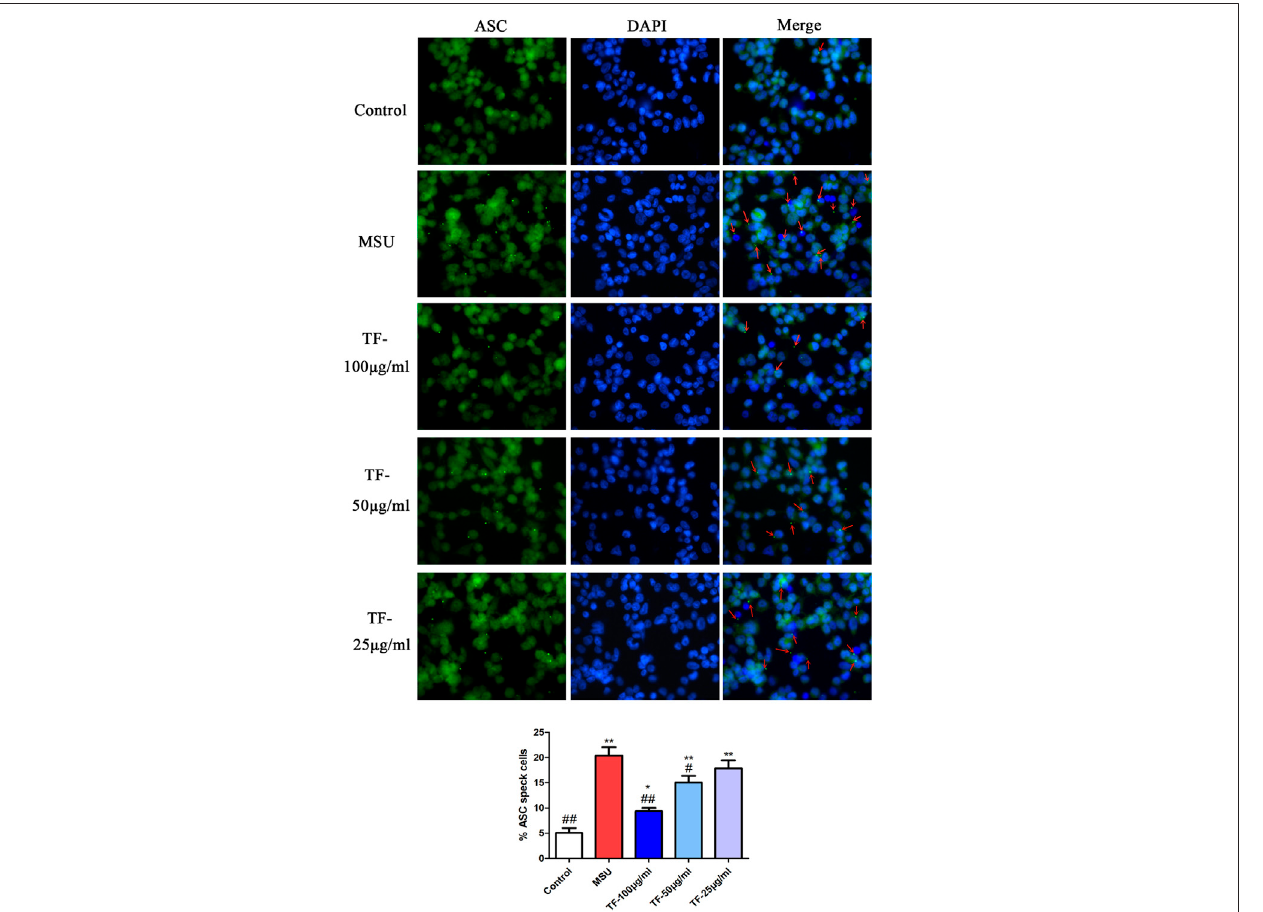
FIGURE 8 | Representative immuno fl uorescence images of ASC speckle. ASC (green) and DNA (blue). Arrow indicates ASC speckle. * p < 0.05 and ** p < 0.01, signi fi cantly different the normal control group; # p < 0.05 and ## p < 0.01, signi fi cantly different the LPS/MSU control group. TF, fl avonoid extract.